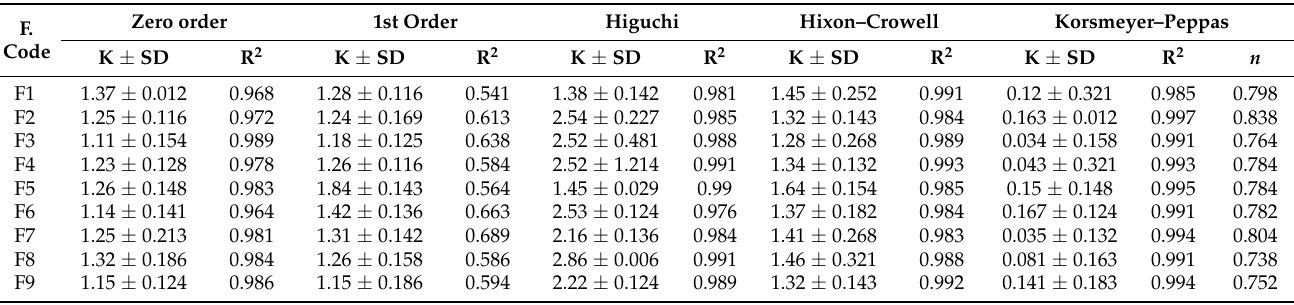
Table 4. Kinetic profiling of methotrexate